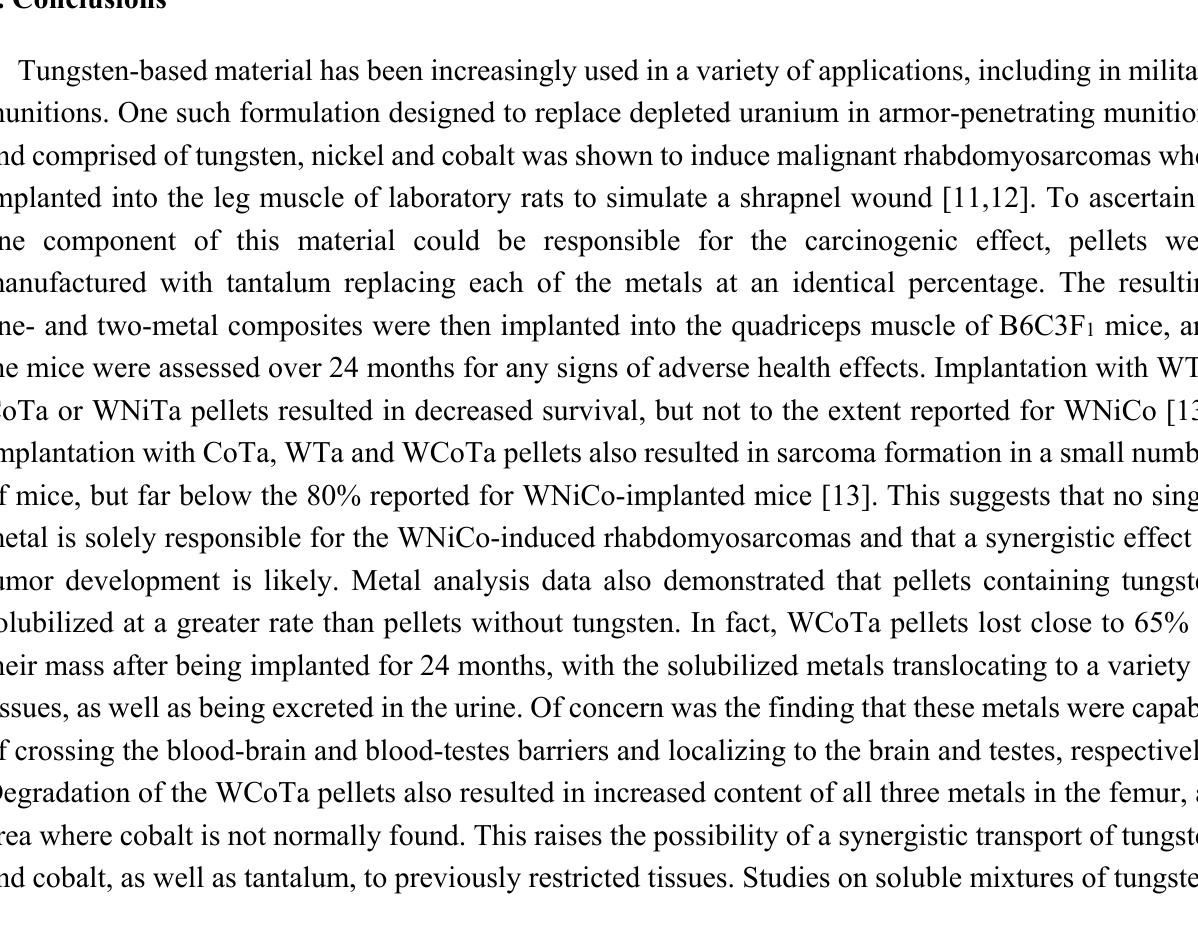
Data represent the mass of the recovered implanted pellets normalized to the mass of the pellets pre-implantation. Data are expressed as the mean of six independent measurements (pellet recovery from six animals per group). Error represents the standard error of the